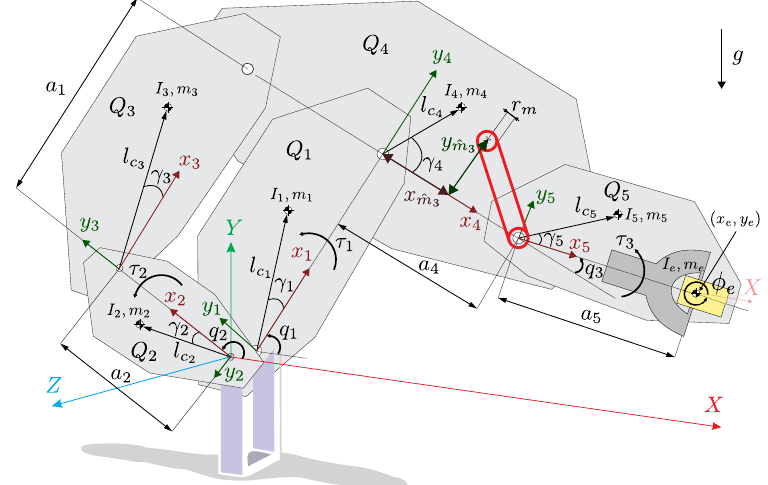
Figure 1. Schematic diagram of the robotic